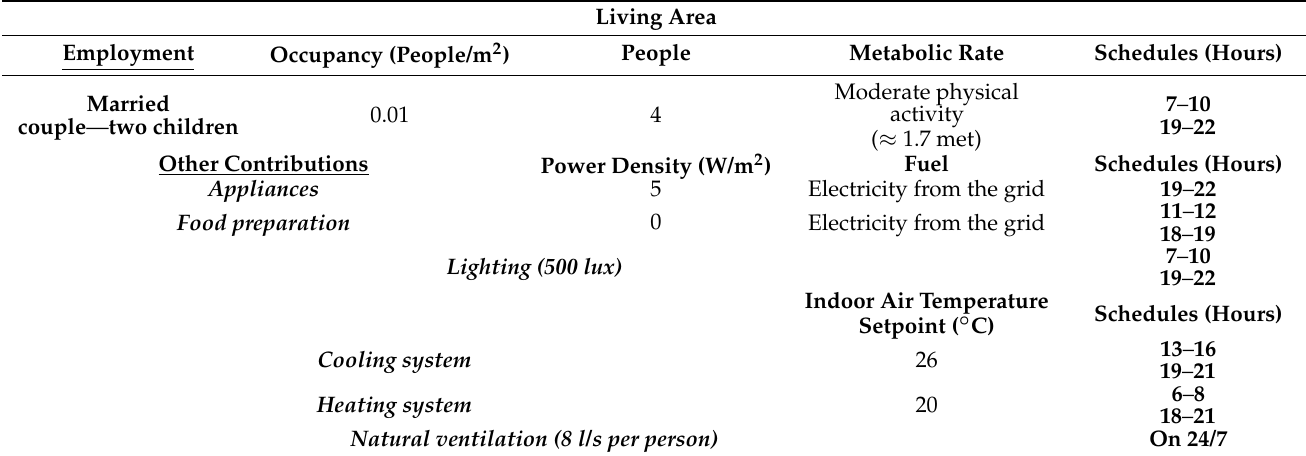
Table 3. Representative schedules for the living area.